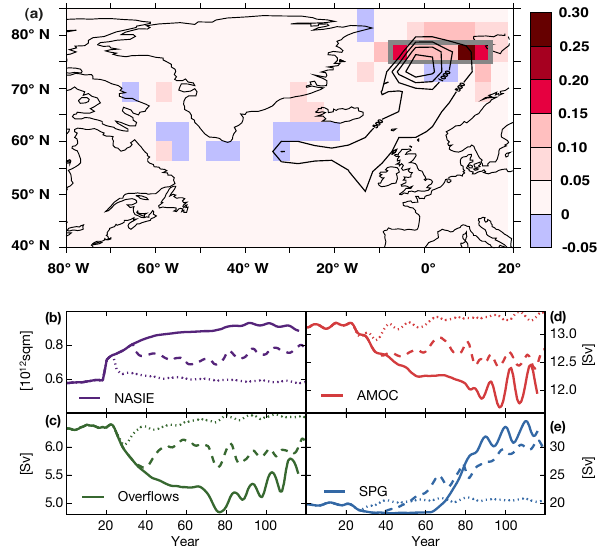
Fig. 5. (a) Difference in annual sea-ice fraction between a decade following a major volcanic eruption (1460–1470) and a reference decade (1440–1450). The sea-ice fraction increase is particularly strong west from Svalbard, which is a key region for deep water formation in our model (February mixed layer depth of the control run overlaid). In a conceptual experiment, the sea-ice extent in this region (grey box) was artificially set to LIA – levels starting from the year 1050. Continuous (straight line), 15yr (dashed) and 5yr forcings (dotted) are compared. Constant and 15yr forcing eventu- ally leads to a rapid increase of NASIE (b) , to a reduction in the GSR-overflows (c) and also in the AMOC at 30N (d) and to a SPG spin-up (e)